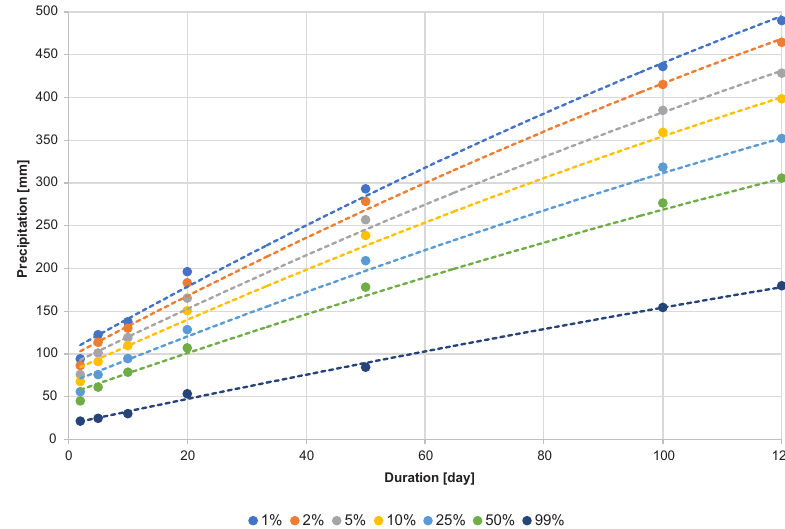
Fig. 10. Distribution of occurrence probability of maximum daily precipitation during the vegetation period, based on data from the iMGW station in Puławy from 1951 to